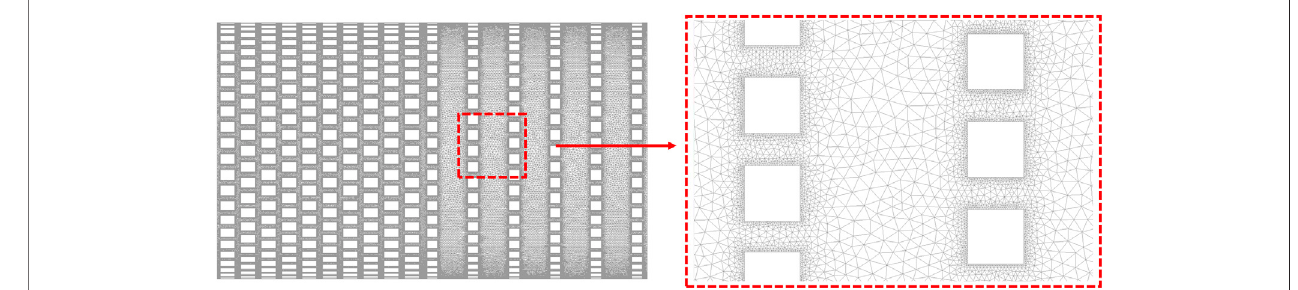
FIGURE 4 | Local mesh